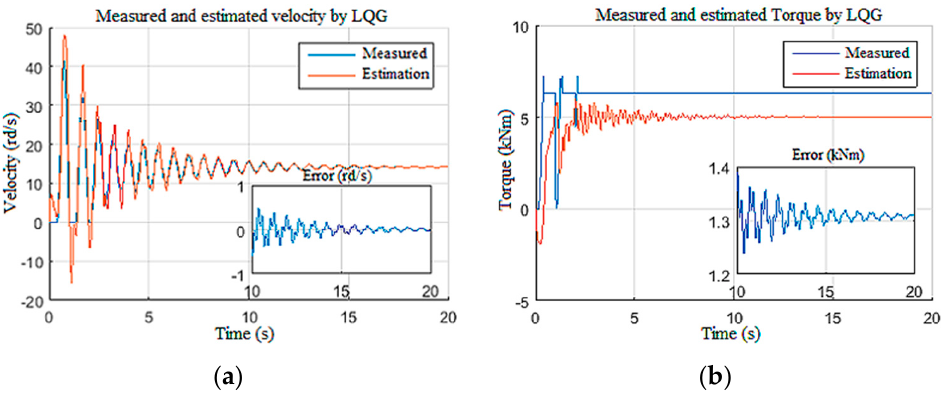
Figure 20. Outputs of LQG from Scenario 4: ( a ) drill bit velocity; ( b ) Tob.